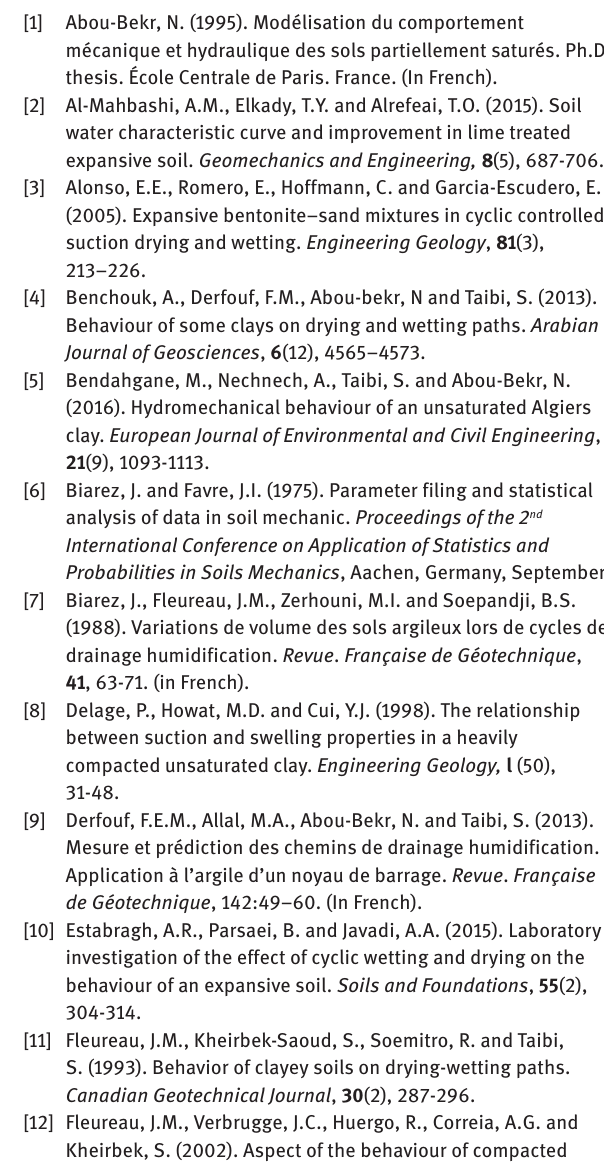
Figure. 9: Comparison between drying-wetting, oedometric compressibility and Biarez and Favre correlation on undisturbed soil samples of Boumagueur